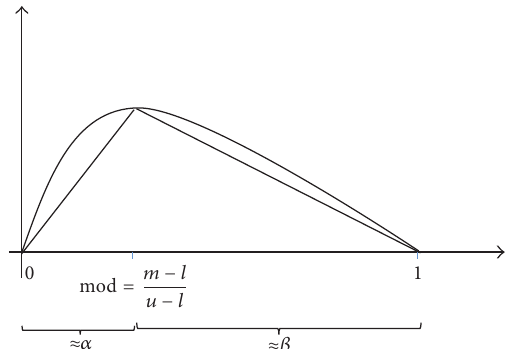
Figure 3: Graph of Beta function corresponding to the triangular fuzzy